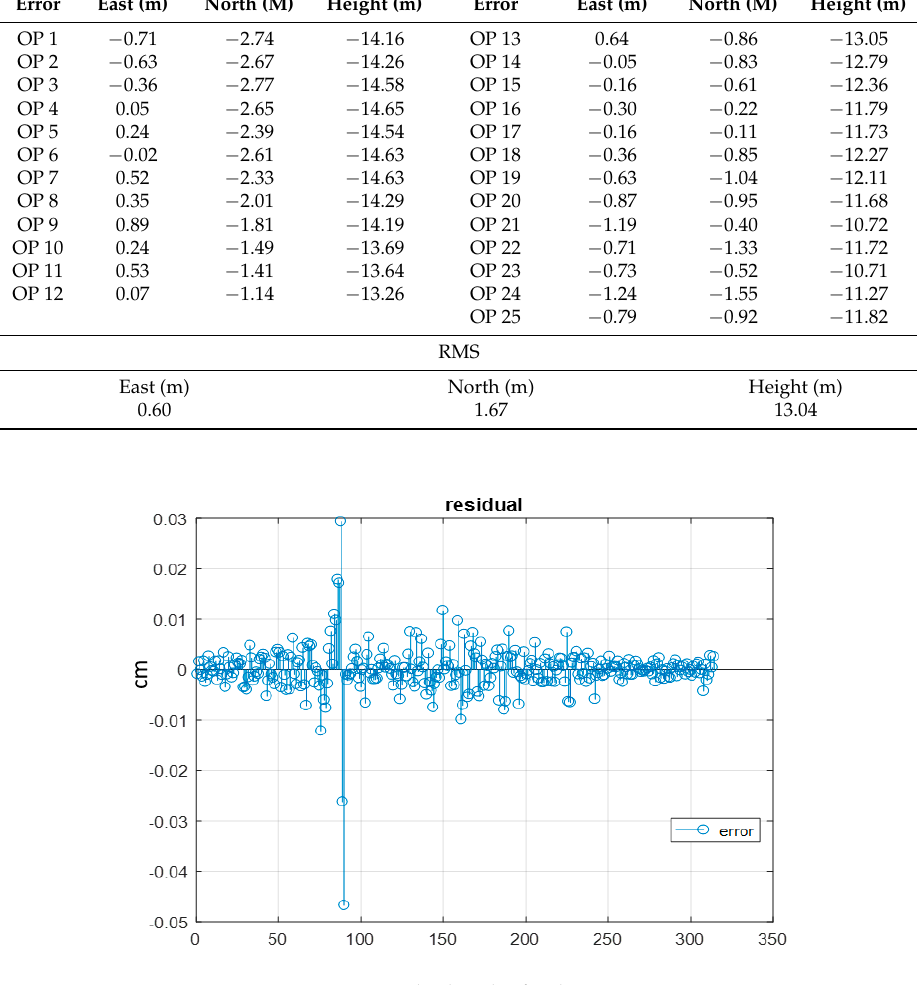
Figure 14. Residual at the final iteration. Table 5. The calculated final 3D ground coordinates of the accuracy of the tie points.